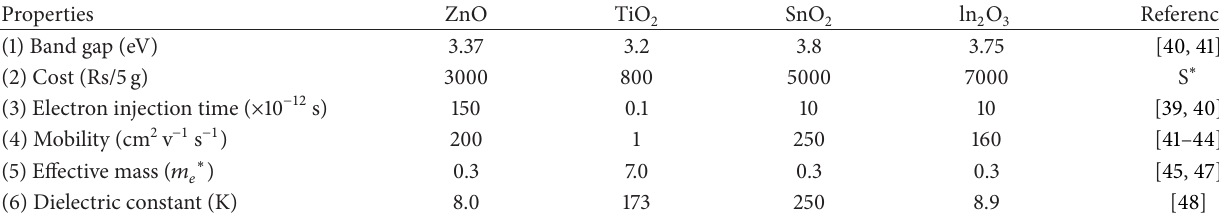
Table 1: Various properties of different possible semiconducting